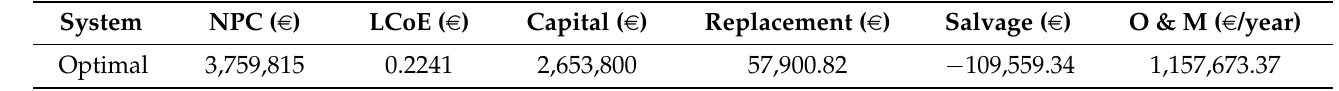
Table 29. Economic characteristics of the optimal configuration of Case 1 Scenario 3.